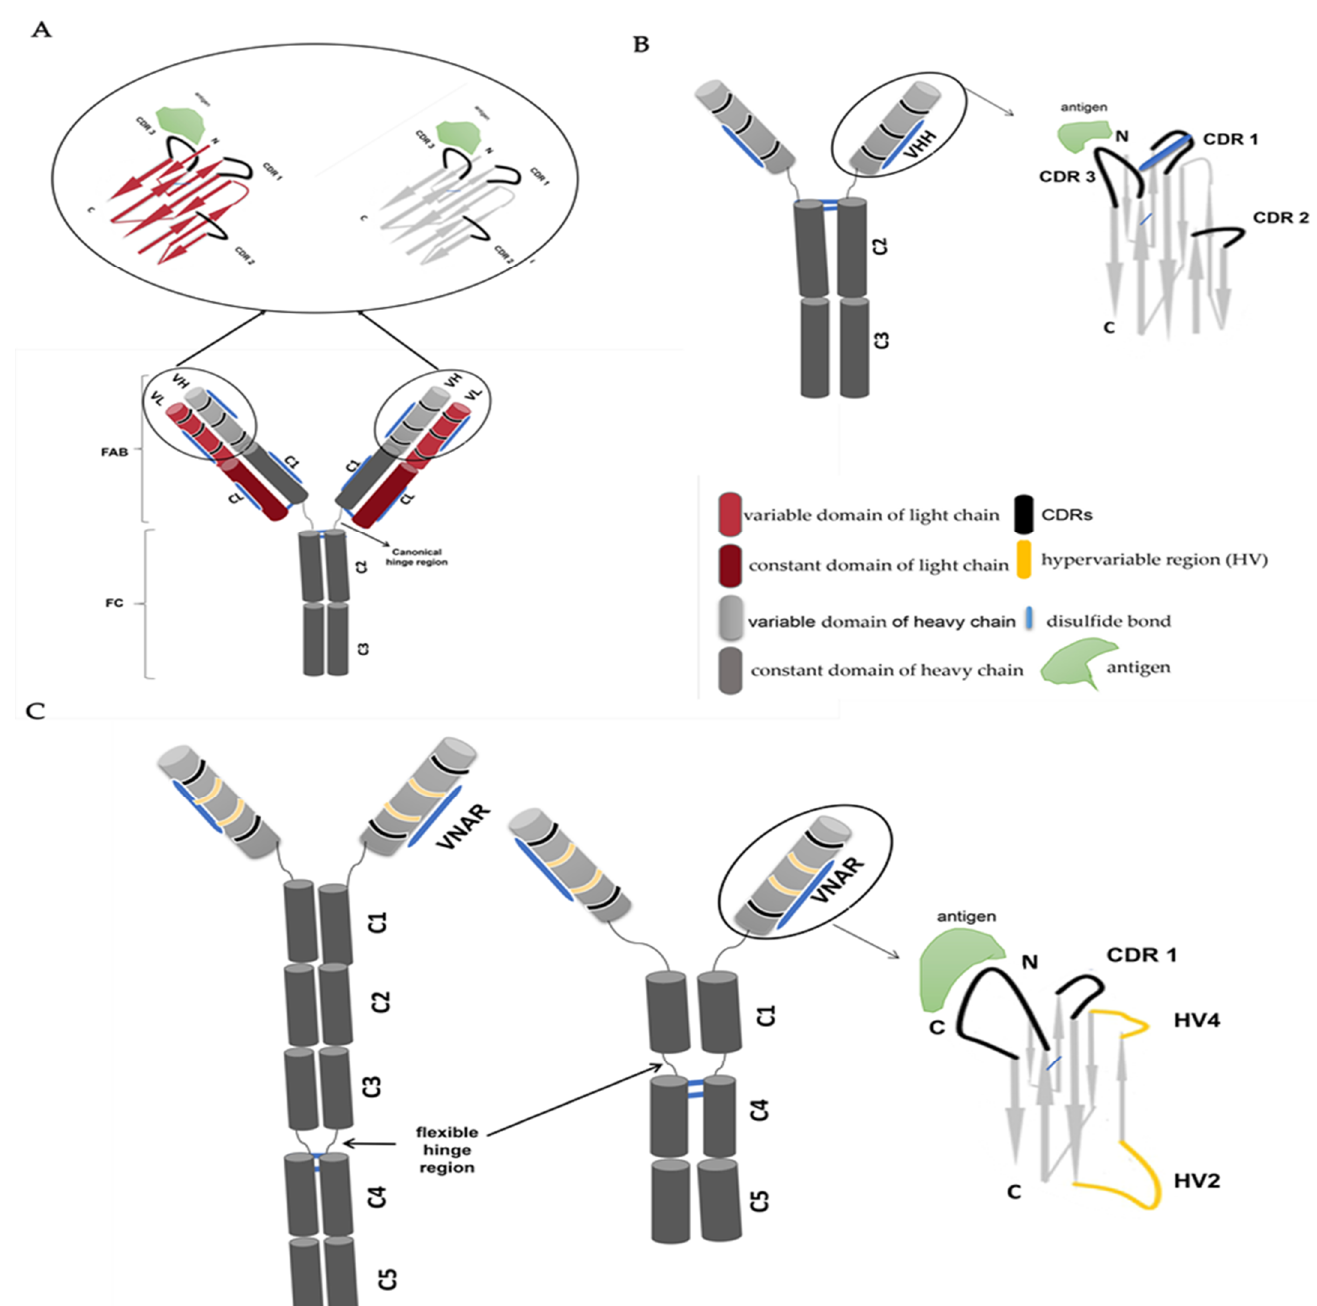
Figure 1. Structure of the antibodies. ( A ) IgG has two identical heavy chains and two identical light chains. ( B ) camelids’ antibodies contain only a heavy chain without the C1 domain. ( C ) shark antibody-containing only heavy chains with hypervariable regions 2 and 4, and a flexible hinge region between C3 and C4. Alternative spliced form of IgNAR in bamboo sharks with only C1, C4, and C5 domains; the variable domain matched the complete form of IgNAR with an extra disulfide bond between CDR1 and CDR3 and HV2 and HV4 chains with the antigen in the long CDR3 as shown in VHH.